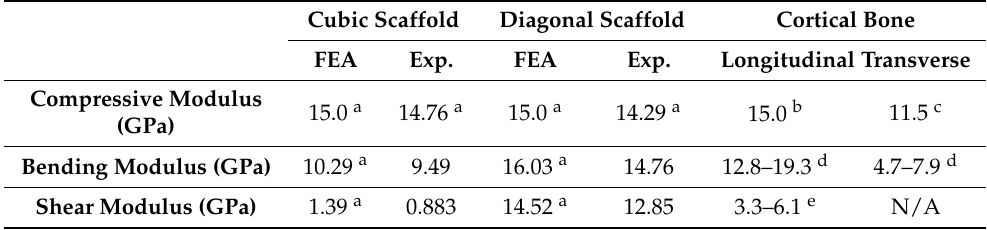
Table 6. Comparison between the elastic stiffnesses of the cubic and diagonal scaffold with the cortical bone properties. Cubic Scaffold Diagonal Scaffold